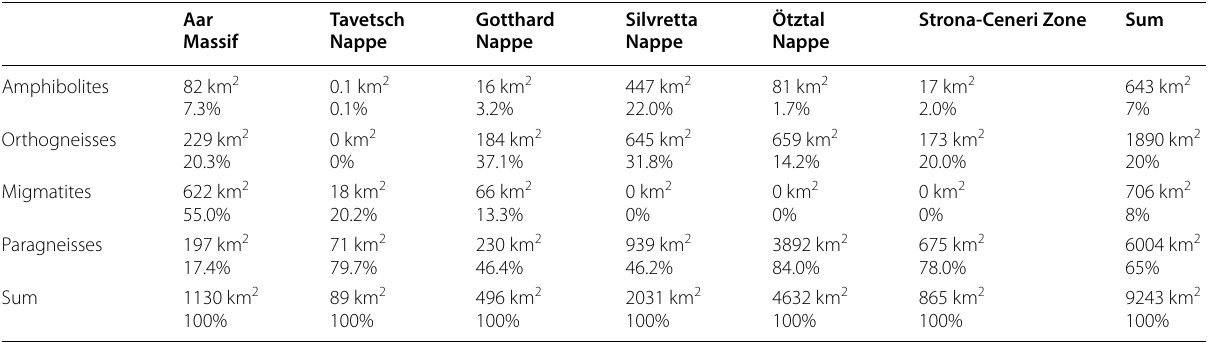
The data is plotted in the diagram of Fig. 6. Analysis is based on data taken from Zurbriggen (2015) for the Strona-Ceneri Zone, Geological Map of Switzerland, 1:500,000 (2008) for the Silvretta Nappe, Egger et al. (1999) for the Ötztal Nappe, and Berger et al. (2016) for the Aar Massif, Tavetsch Nappe and Gotthard Nappe. Note: In case of the Aar Massif, the Gärsthorn Gneiss Complex was classified as orthogneiss, Guttanen and Lötschental Gneiss Complexes as paragneisses, and the Ofenhorn-Stampfhorn, Erstfeld, Innertkirchen-Lauterbrunnen and Massa Gneiss Complexes as migmatites